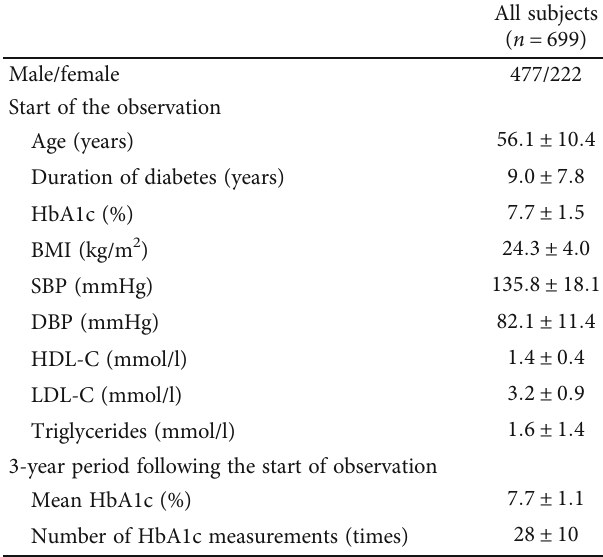
Table 1: Clinical characteristics of all